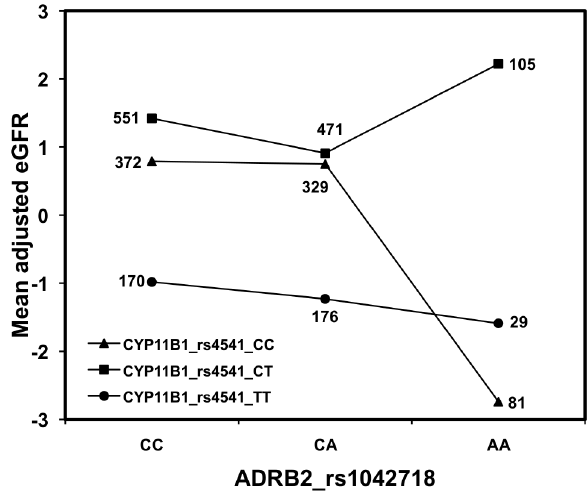
Figure 3. Mean adjusted eGFR as a result of the genotypic interaction between CYP11B1_rs4541 and ADRB2_rs1042718. The data points represent the eGFR for the nine possible combinations of the three ADRB2 genotypes versus each of the three possible CYP11B1 genotypes. The number of individuals at each point is